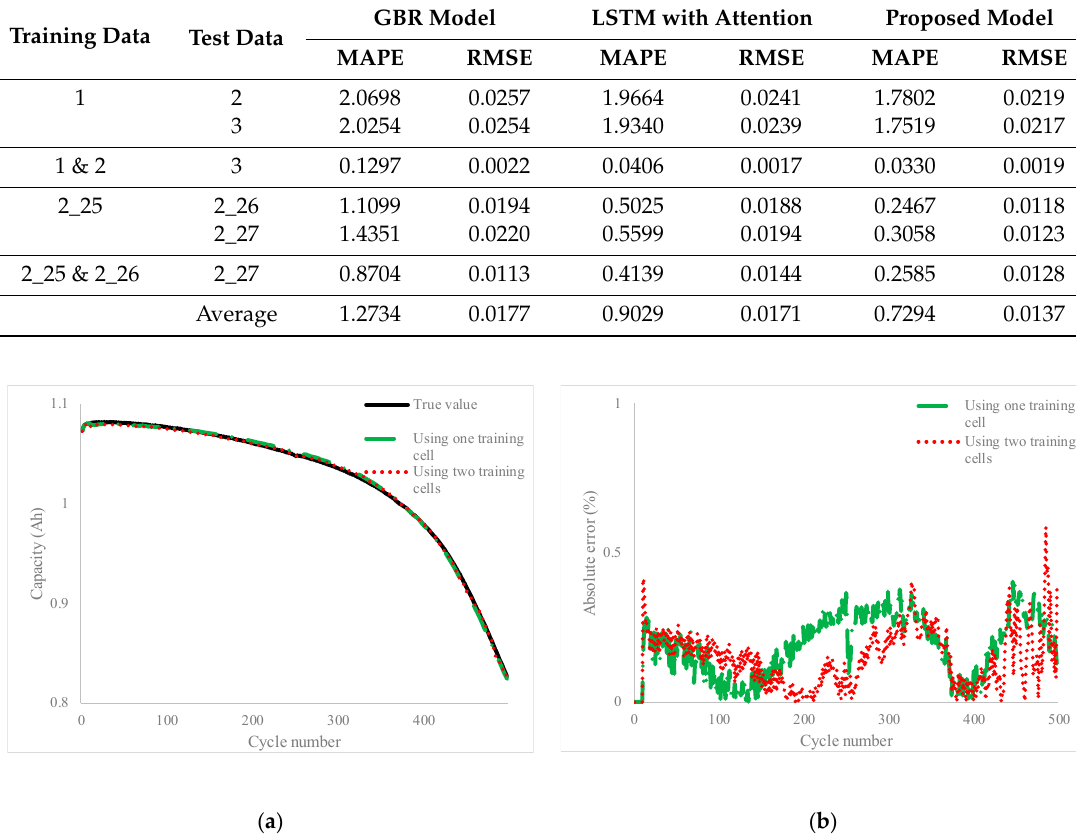
Table 6. The cycle life prediction results of different models using 70% of the total data as training data.